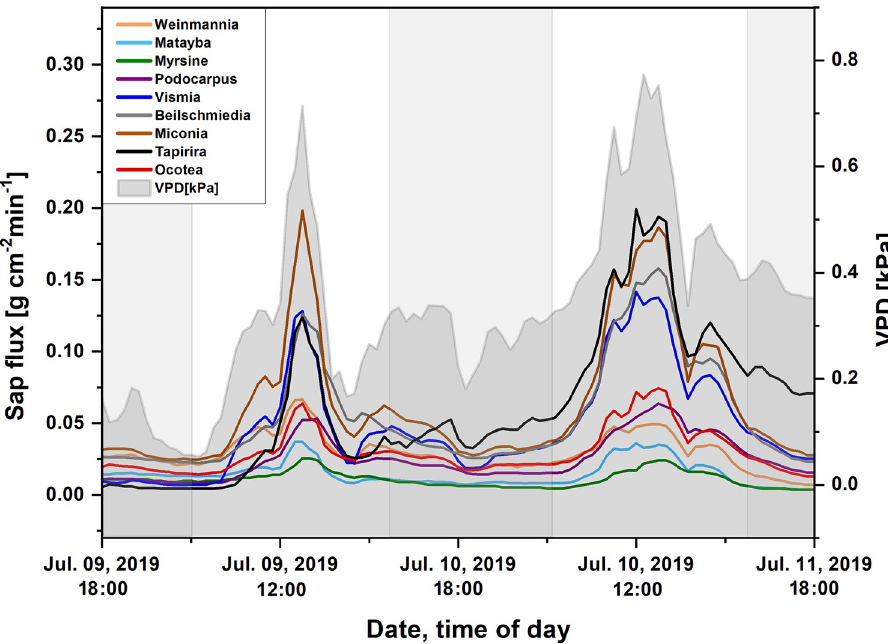
Fig 5. Normalized sap flux (g cm -2 min -1 at a depth of 2.8 cm) of individuals of nine tree species growing on the research plot in the evergreen mountain rainforest in the Reserva Biolo´gica San Francisco. The data are means of the recordings of three sensors per tree. The grey background shows the atmospheric water vapor pressure deficit (VPD). Vertical light grey bars indicate night hours. (n =